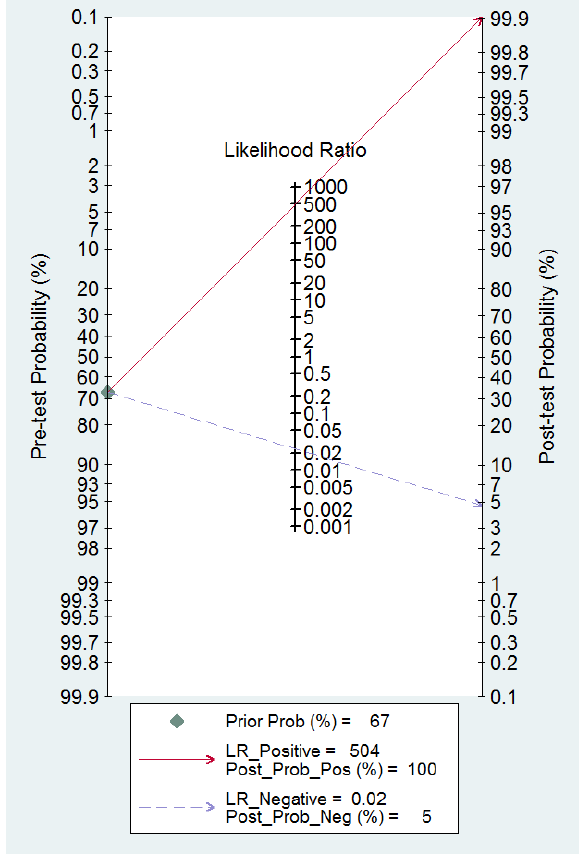
Figure 12. Fagan nomogram for three-dimensional transvaginal ultrasonography. It can be observed how the test changes the pre-test probability depending on a positive or negative result.